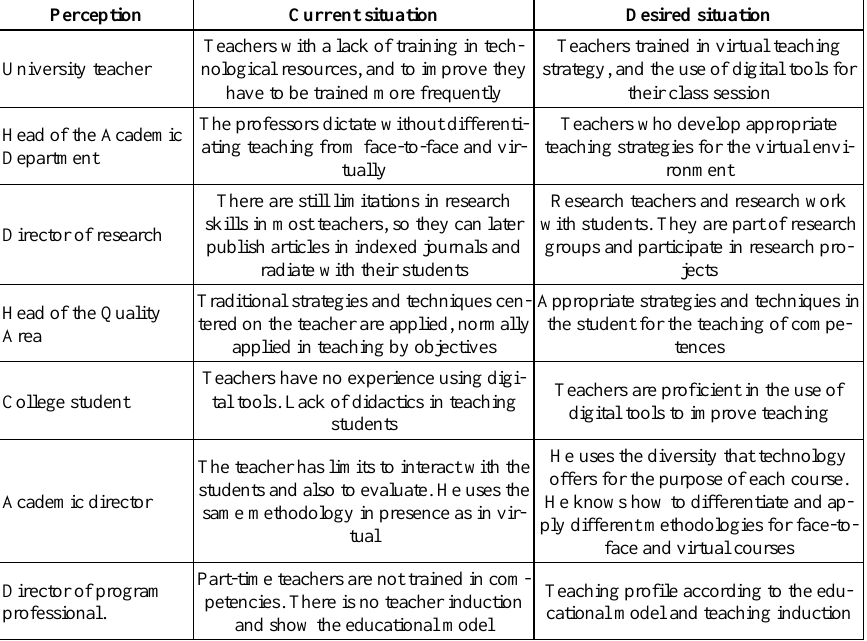
Table 1. Current status of the interview of all individuals